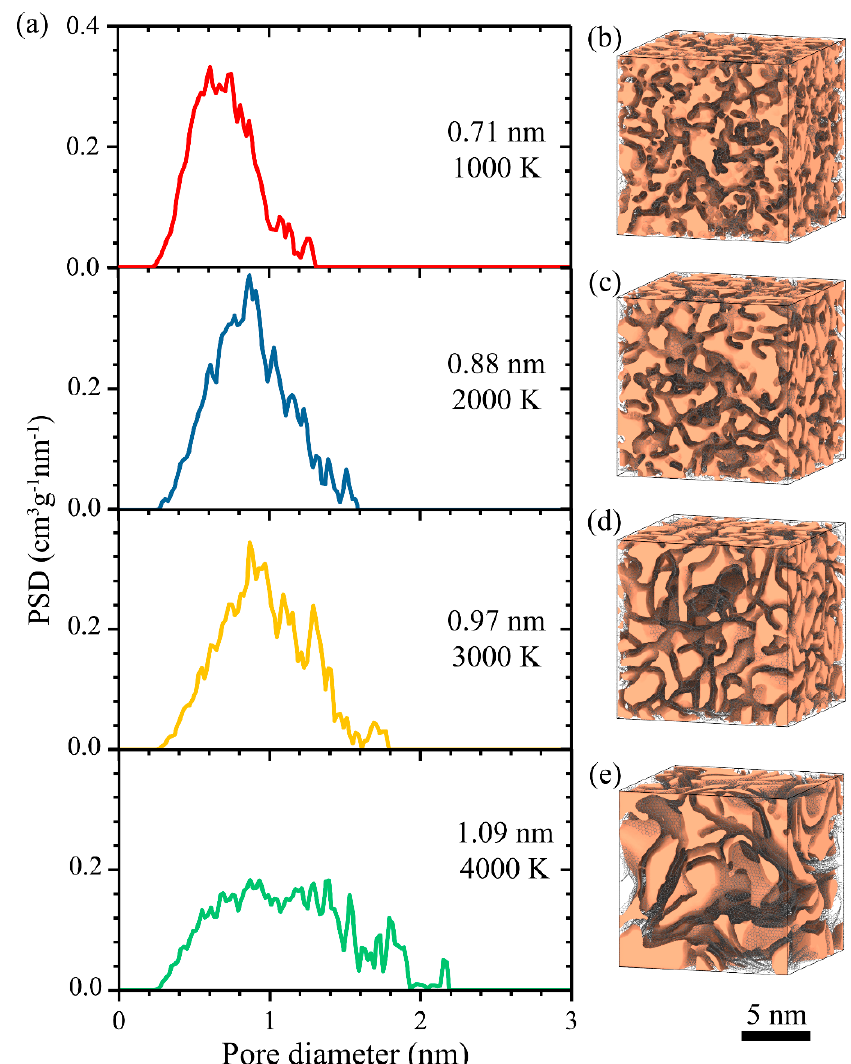
Figure 6. ( a ) Pore size distributions for several DGNs annealed at different temperatures. The average pore size is shown in each panel. The corresponding rendered images of open pores are in ( b – e ).